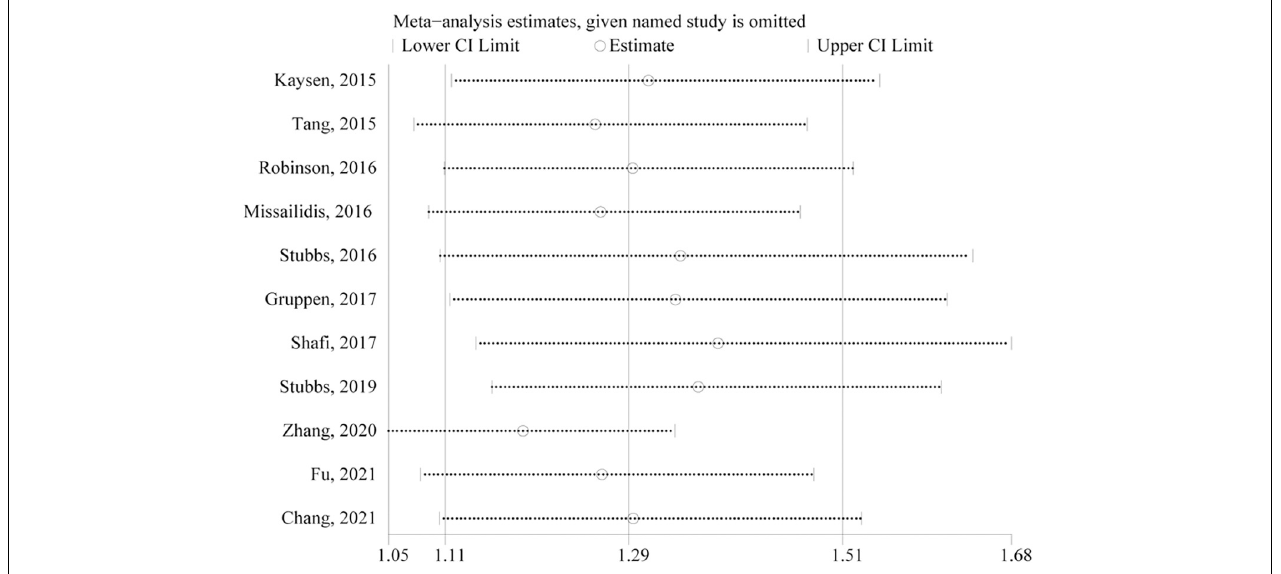
FIGURE 5 | Sensitivity analysis of the association between circulating TMAO and all-cause mortality risk. CI, confidence interval.